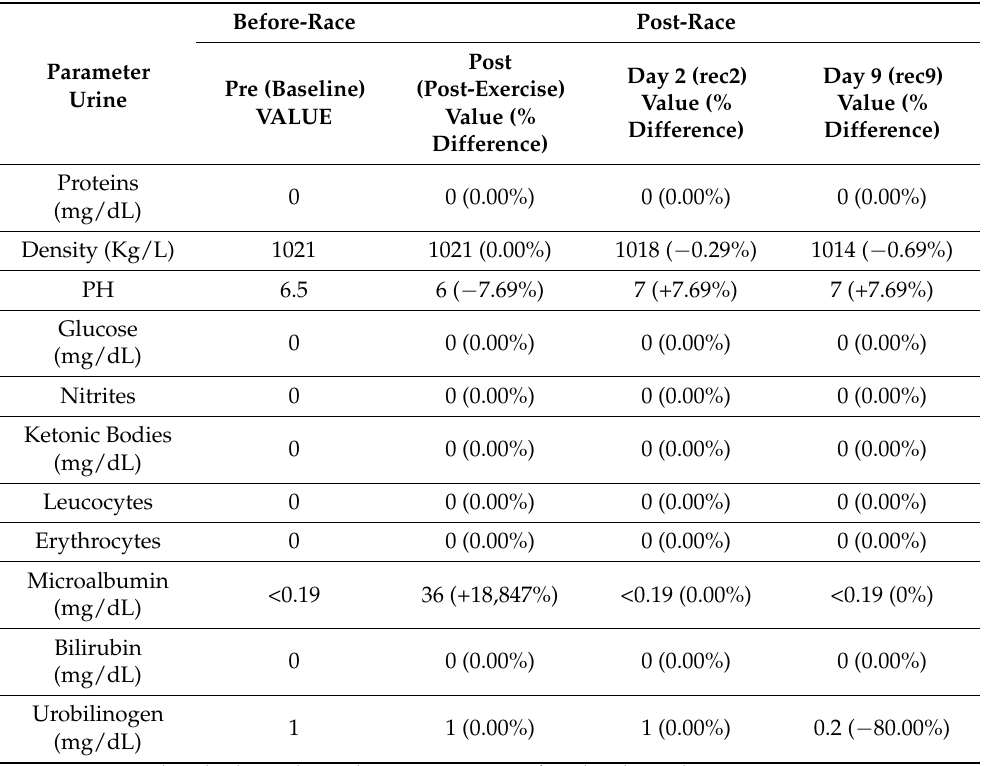
Table 2. Urine Parameters Before (Baseline) and After Race (Post-Exercise Day 2 and post-exercise Day